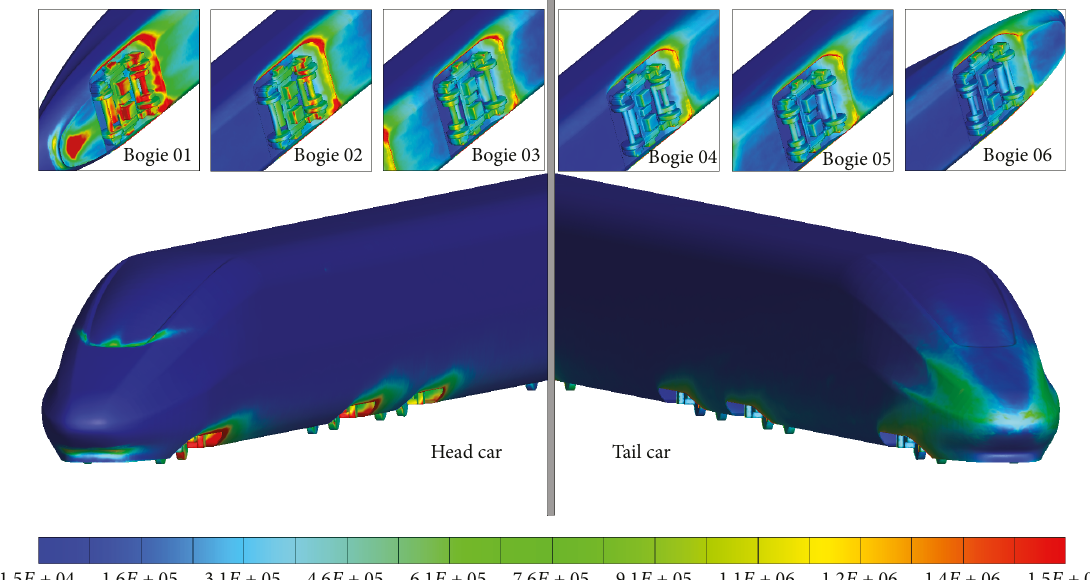
′ on the high-speed train (units: Pa/s; free fl ow speed: 83 m/s). Figure 12: Contour of p rms